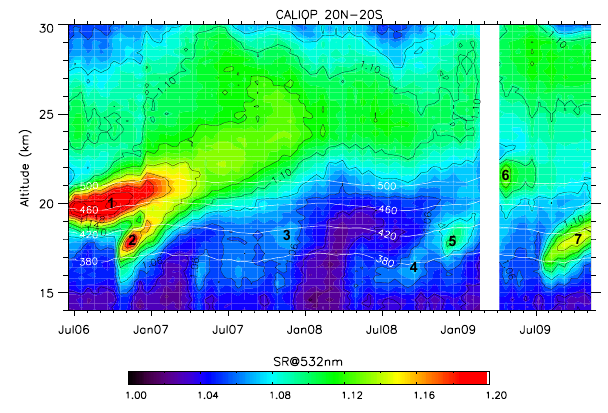
Fig. 1. Mean CALIOP Scattering Ratio (SR) (contour steps 0.02) between 14–30km and 20 ◦ S–20 ◦ N from June 2006 to October 2009 after removing cloudy pixels of depolarization ratio at 532nm greater than 5%. The precision of the SR profiles is 2%, the vertical resolution 200m and the time resolution 16 days. Shown by white lines are temperature potential levels at 380, 420, 460 and 500K. Each identified plume is indexed and listed in Table 1.